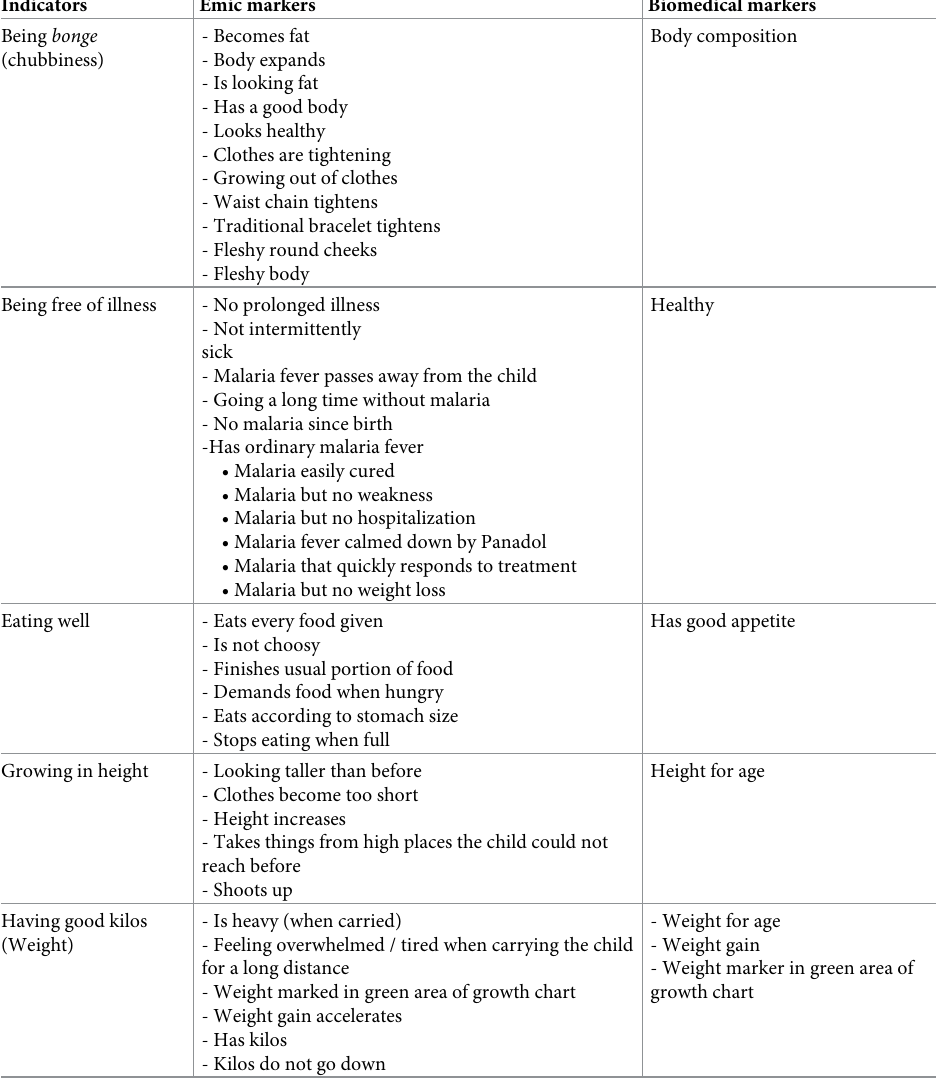
Table 2. Healthy growth markers as identified by the study participants and biomedical